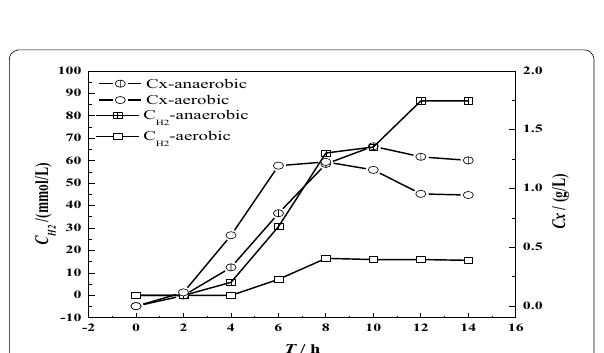
Fig. 6 Cell growth ( C x ) and hydrogen production ( C H2 ) of EB-06 in anaerobic and aerobic